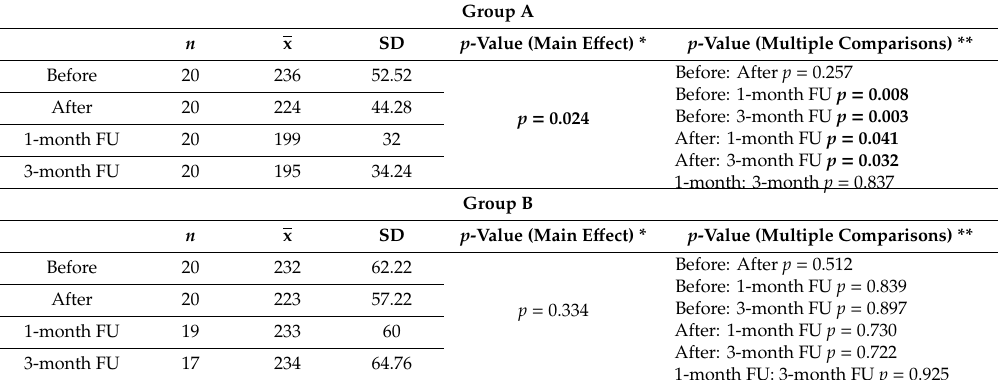
Table 2. Results of the total sway path (TSP) with open eyes in both groups (mm). Group A n x SD p -Value (Main E ff ect) * p -Value (Multiple Comparisons) **